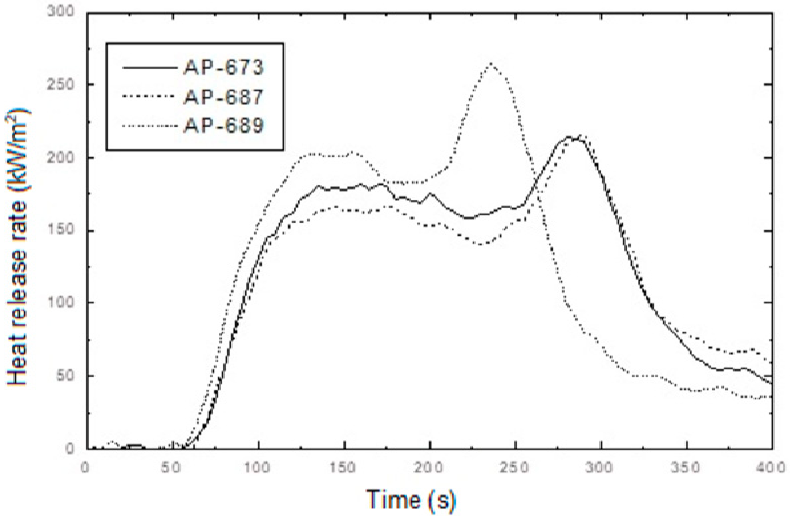
Figure 15. Heat release rate curves of AP ‐ 673, AP ‐ 678 and AP ‐ 689 as a function of burning time.